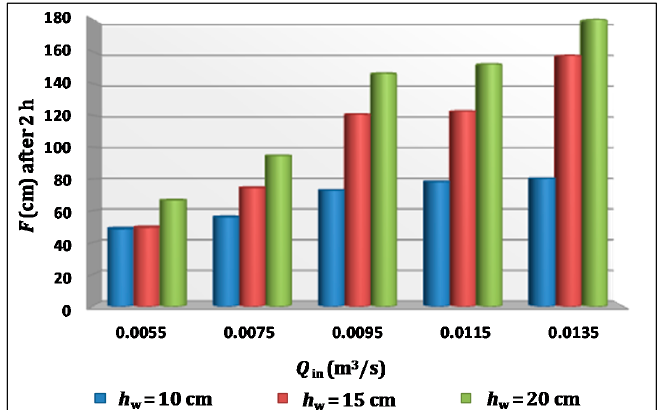
Figure 8. The values of cumulative infiltration, F , in the grassed channel after 2 h for different check dam heights.